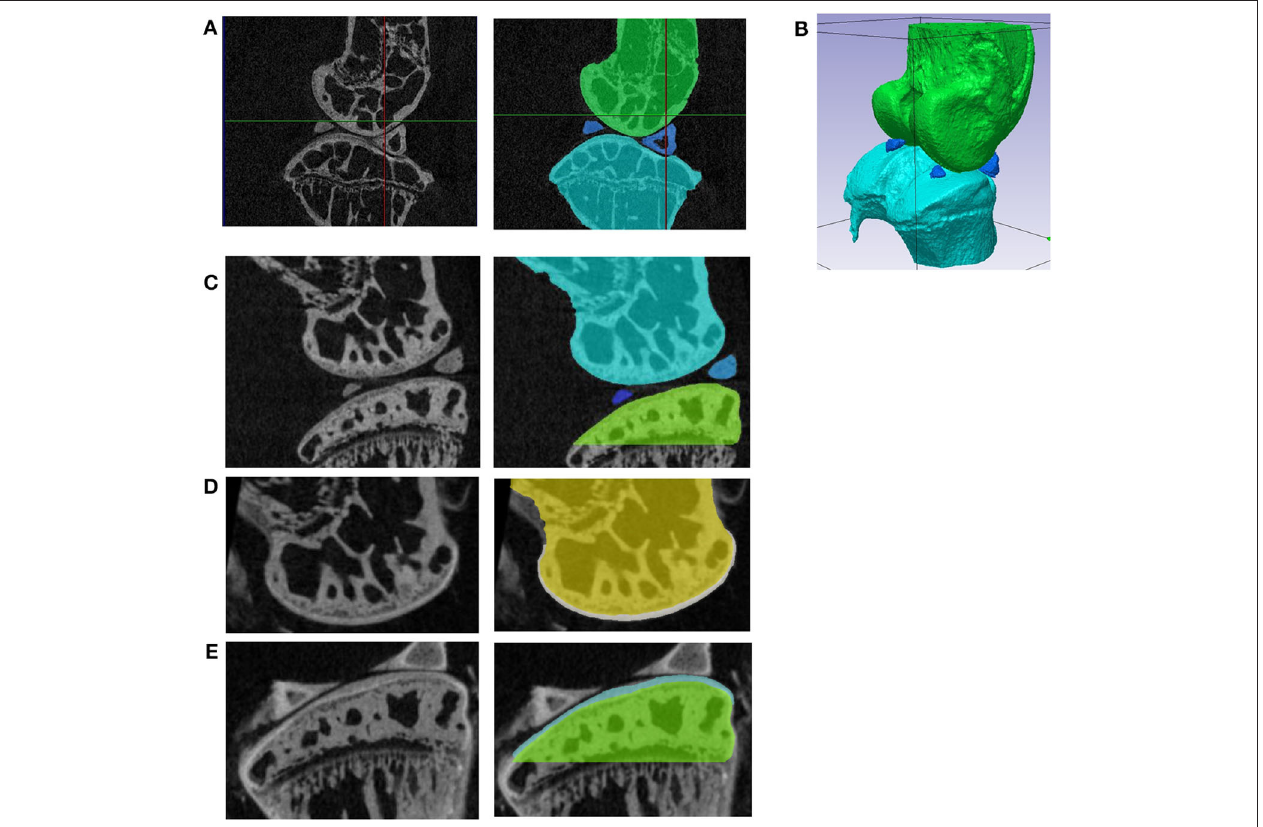
FIGURE 1 | (A) Sagittal section of the microCT image of the unstained specimen with the joint in the rest position; segmentation of the femur (green), tibia (light blue), and calcified menisci (dark blue); (B) 3D view of the segmented bones in the resting position; (C) sagittal section from the microCT image acquired before staining (left) and segmentation of the bone tissue (right). The images of the femur (D) and tibia (E) from the microCT scans acquired after staining (left) were registered to the images in (A) and the cartilage was segmented (right). In (E) portions of the menisci that could not be removed during the dissection without risk of damaging the cartilage are